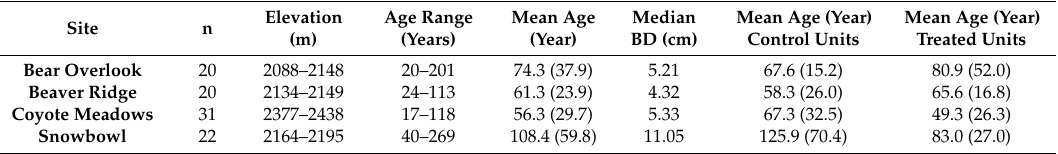
Table 3. Age (yrs) and basal diameter (BD; cm) characteristics of the trees in the control and treatment units at the four sites. n is the sample size from each site. Age range: youngest to oldest sample trees from the site. Mean age: average age of all trees from the site with standard deviation in parentheses. Median BD: median basal diameter (cm) of trees sampled. Mean control age: average age of the trees sampled in the control units, standard deviation in parentheses. Mean trt. age: average age of the trees sampled in the treatment units. Median BD was used rather than the mean due to the modest sample size at each site and the presence of large BD trees, which disproportionally raised the average BD of the